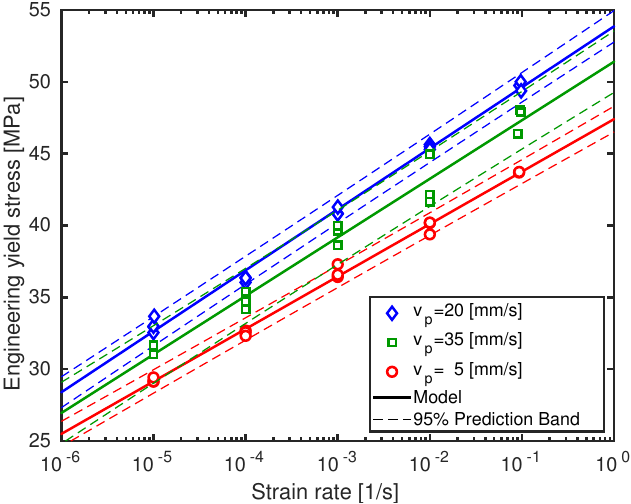
Figure 3. Engineering yield stresses and 95% prediction bands as a function of logarithmic strain rate for samples processed at three different printing velocities. Symbols are experimental results, solid lines are model